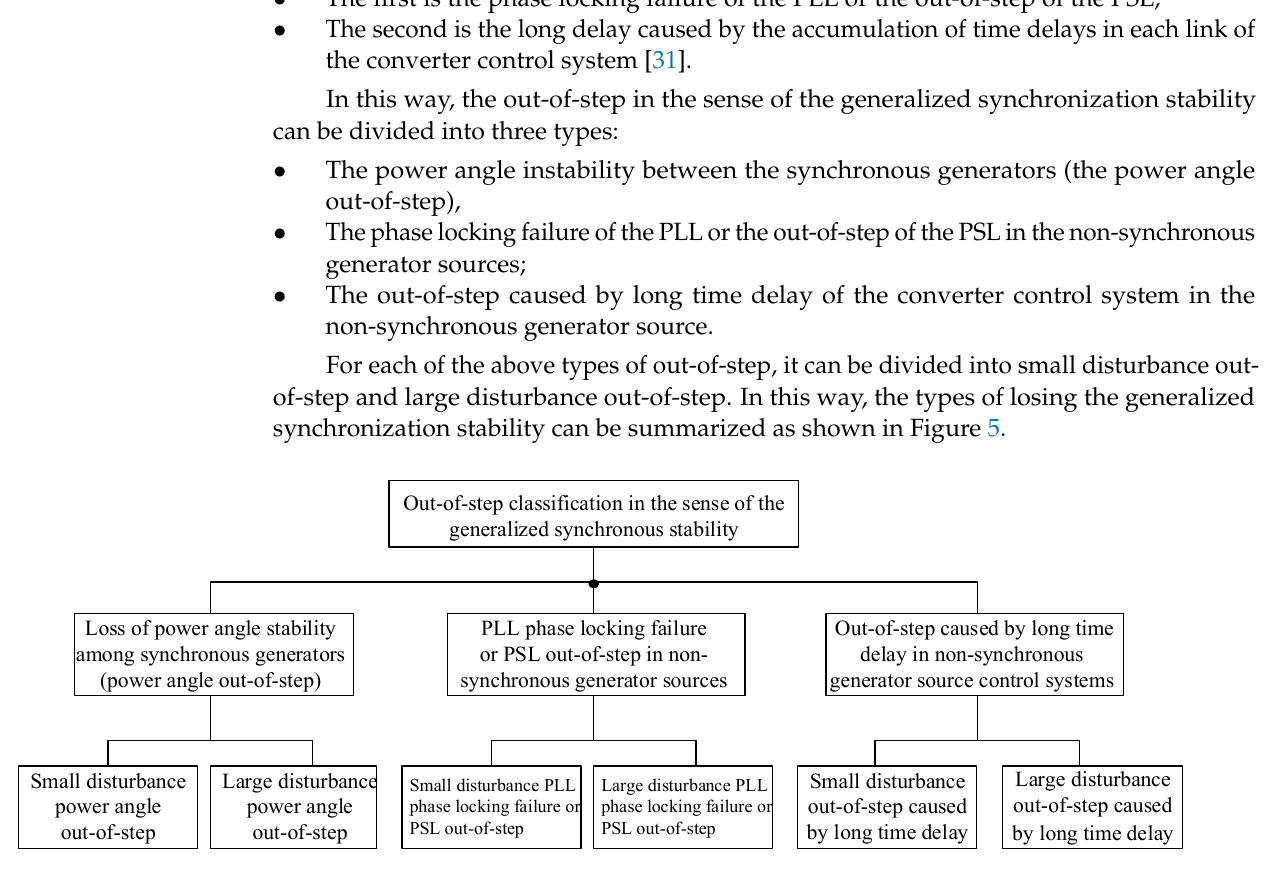
Figure 5. Types of losing the generalized synchronization stability.